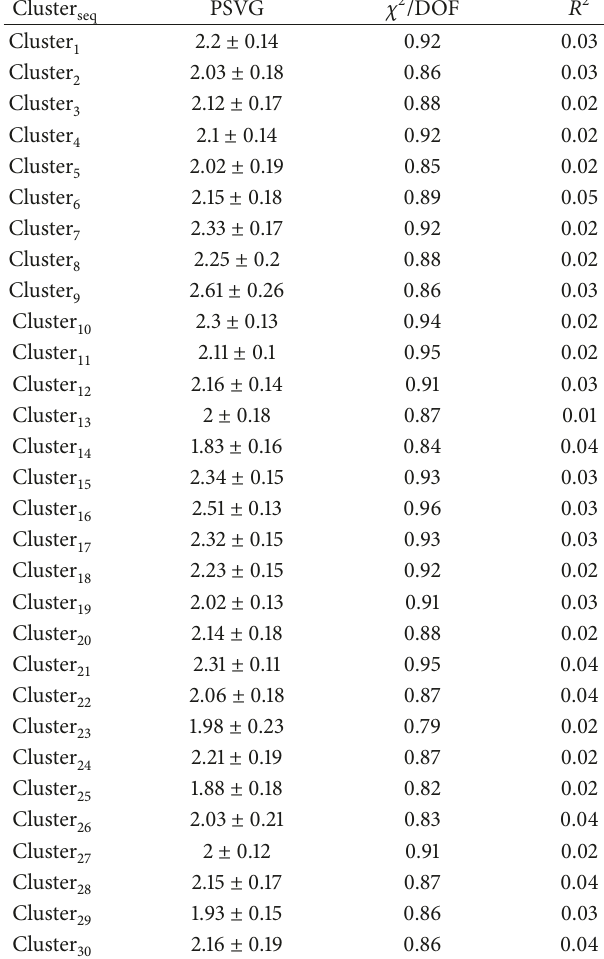
Table 1: List of PSVG values calculated for the visibility graphs constructed from a sample set of 30 cluster data sets extracted from the visibility graph corresponding to one of the four data sets of 𝜙 - values for 32 S-AgBr (200A GeV) interaction data (constructed in step (1)